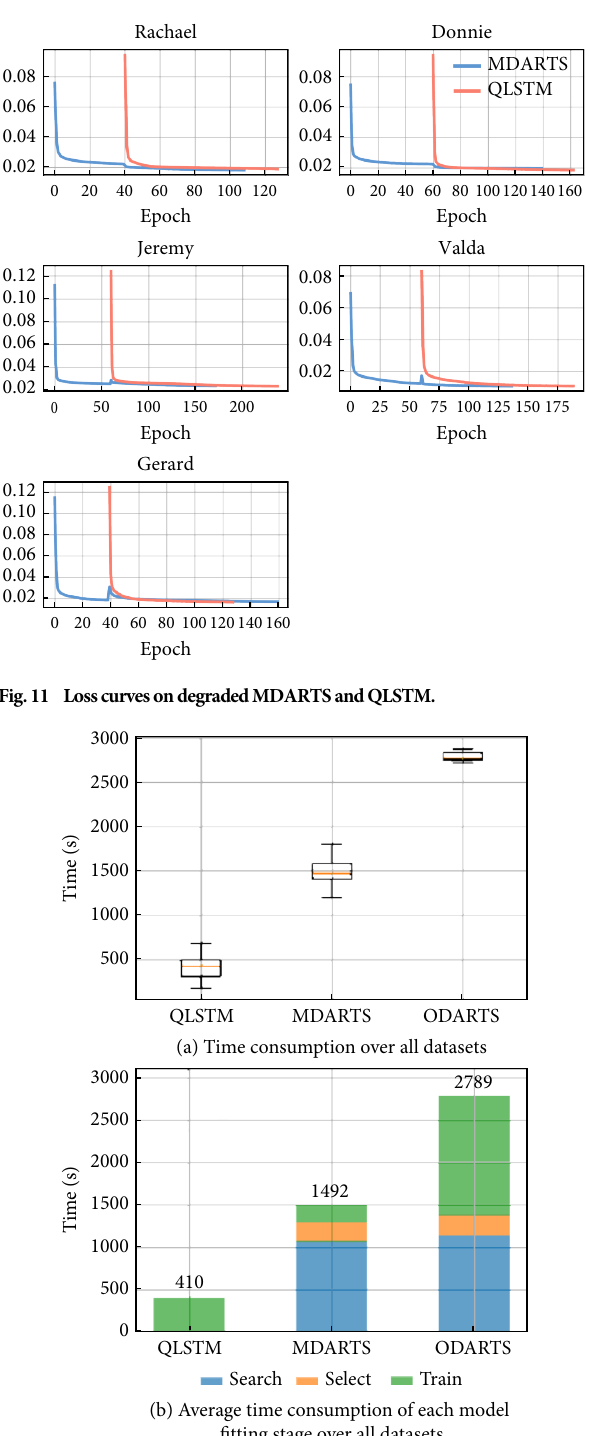
figure. Without the searching and selecting process, QLSTM takes